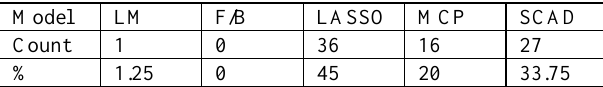
Table 1. Count and percentage of best performing models